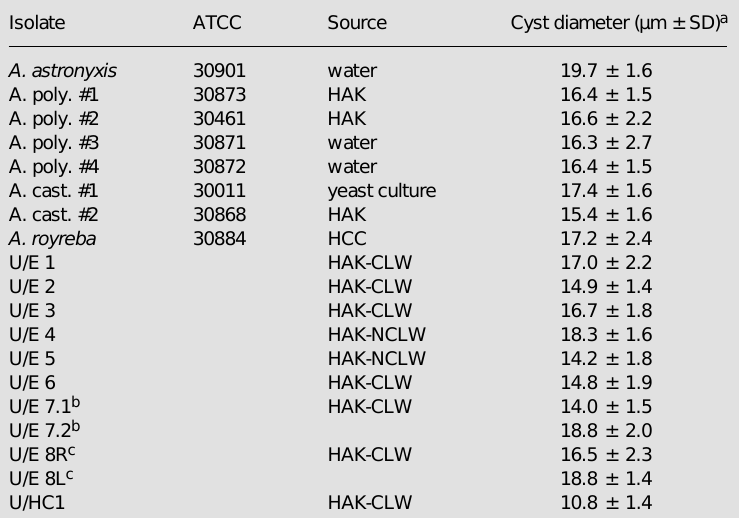
Table 1 - Characteristics of Acanthamoeba